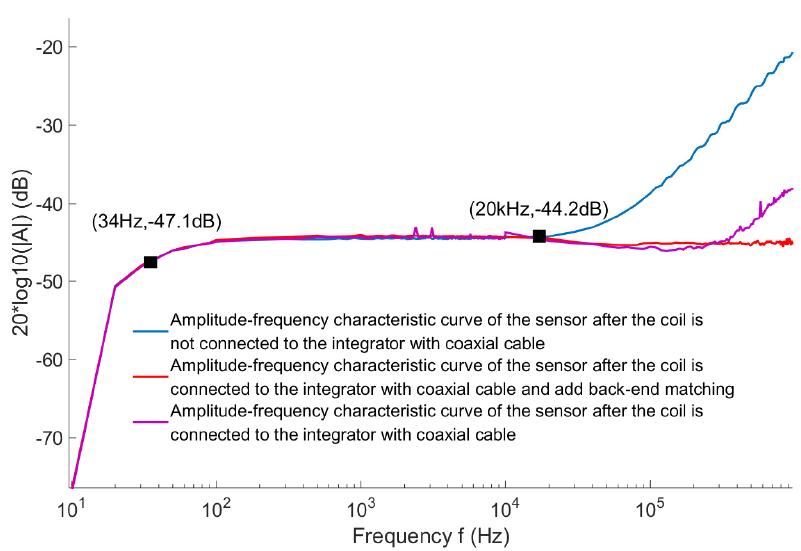
Figure 17. Amplitude-frequency characteristic curves of the sensors with different integration states.